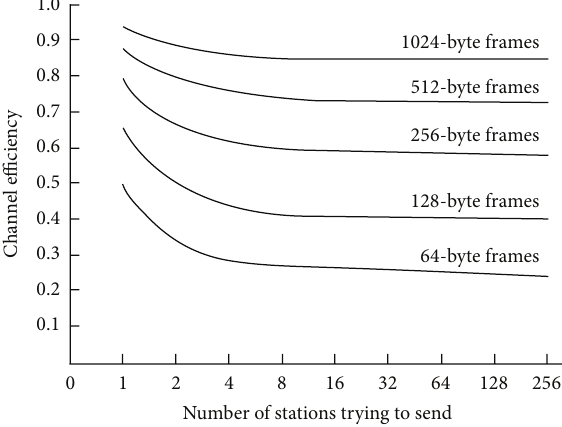
Figure 18: Channel efficiency over the total packet size with TCP overhead 20 bytes